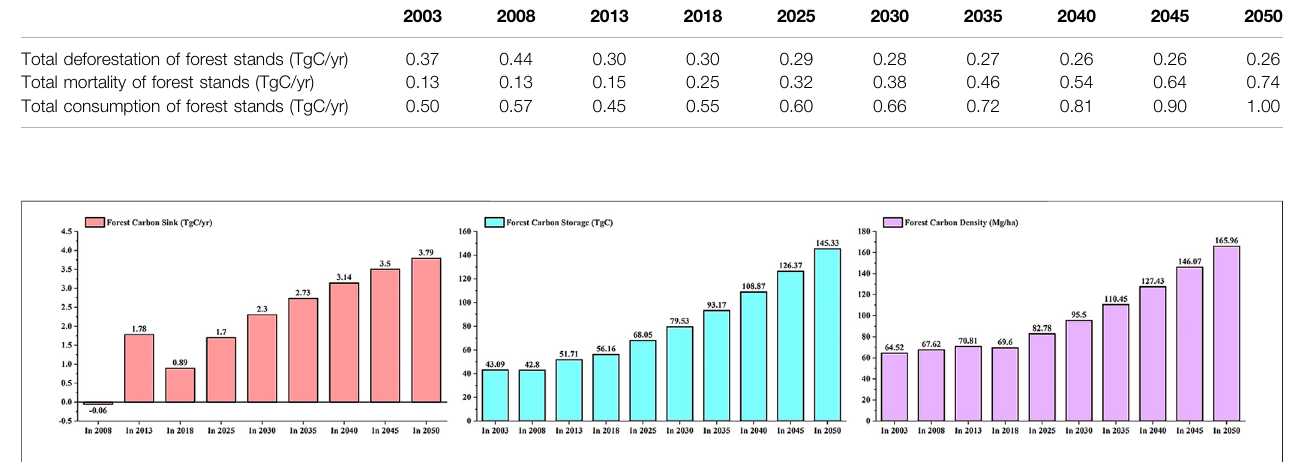
Total deforestation of forest stands (TgC/yr)